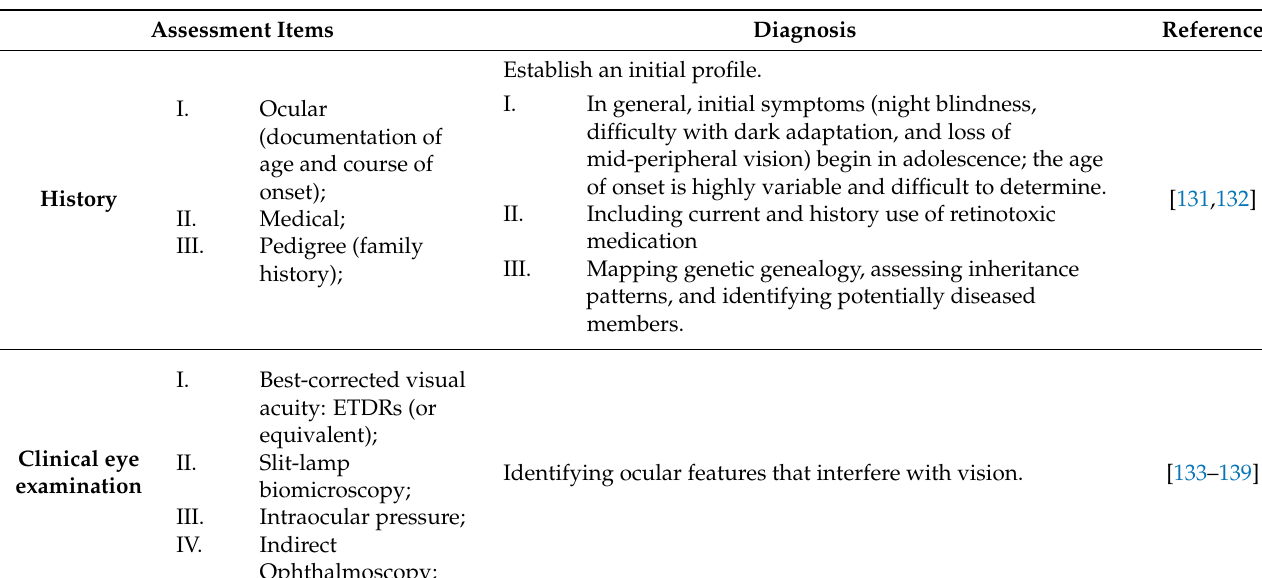
Table 1. RP clinical evaluation and diagnostic